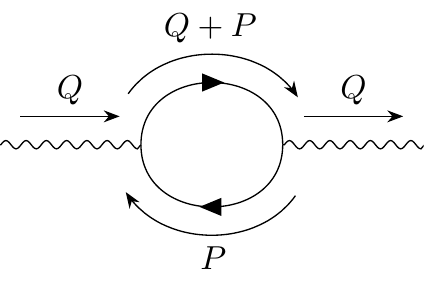
Figure 1 . The one-loop diagram in spinor